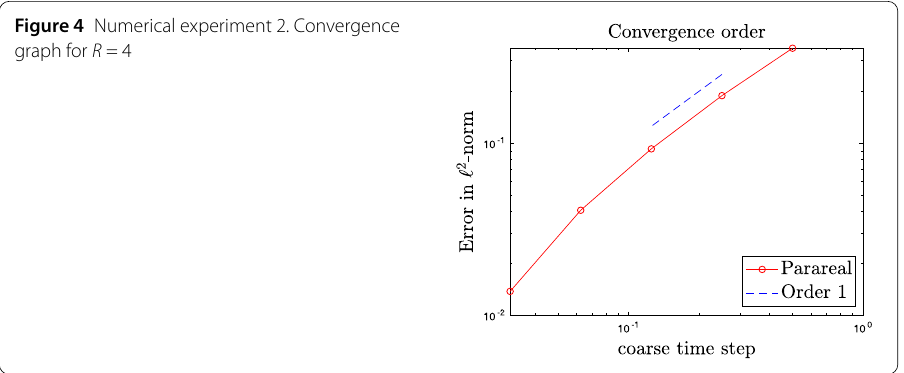
Figure 4 Numerical experiment 2. Convergence graph for R =